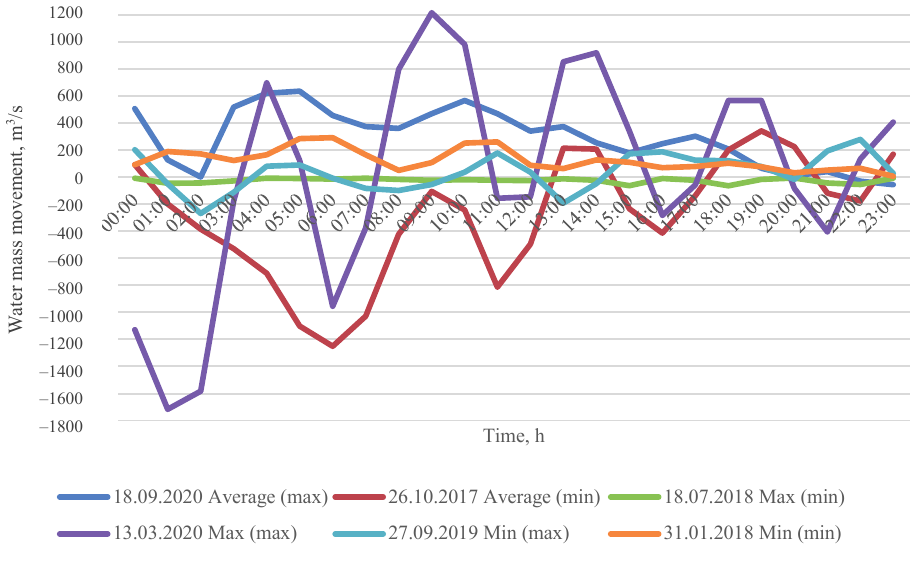
Fig. 4. Extreme values of water mass movement for 2017–2021 at the observation station